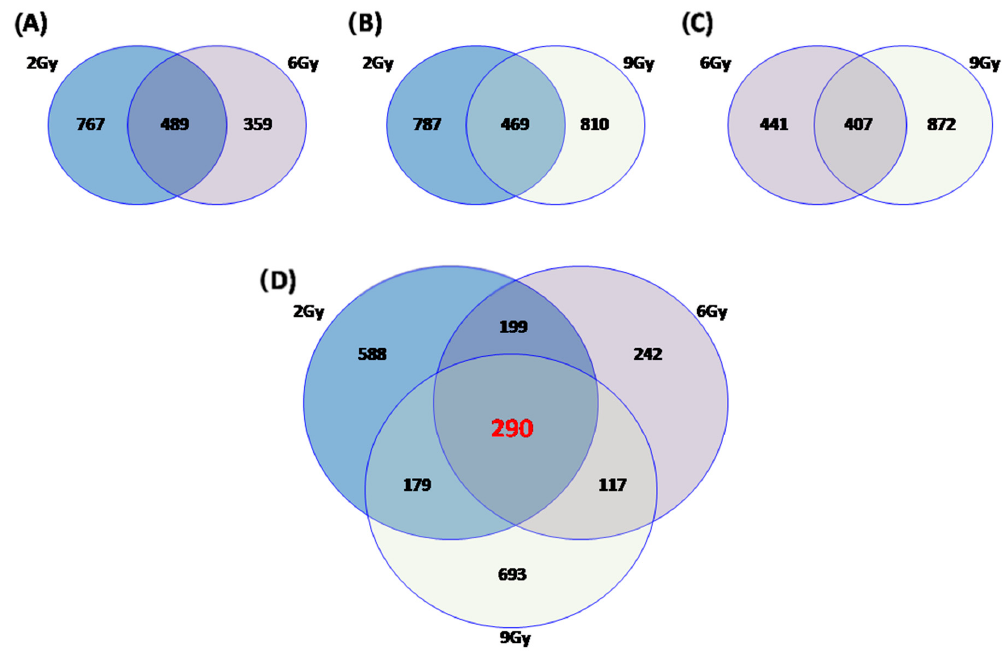
Figure 3. Venn diagram of the number of unique and shared differentially expressed genes after proton irradiation in MDA-MB-231 xenograft mice using 2, 6 and 9 Gy of radiation doses as follow: ( A ) unique and shared differentially expressed genes in samples treated with 2 and 6 Gy; ( B ) unique and shared differentially expressed genes in samples treated with 2 and 9 Gy; ( C ) unique and shared differentially expressed genes in samples treated with 6 and 9 Gy; ( D ) unique and shared differentially expressed genes in samples treated with 2, 6 and 9 Gy.